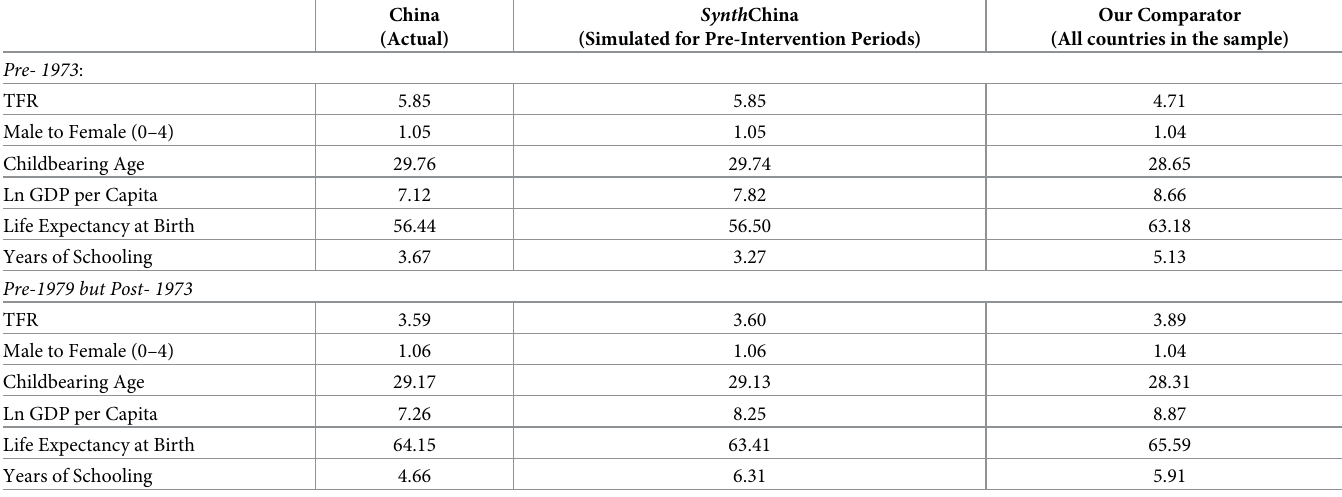
Table 1. Averages of Pre-intervention characteristics of China, SynthChina, and the comparator.